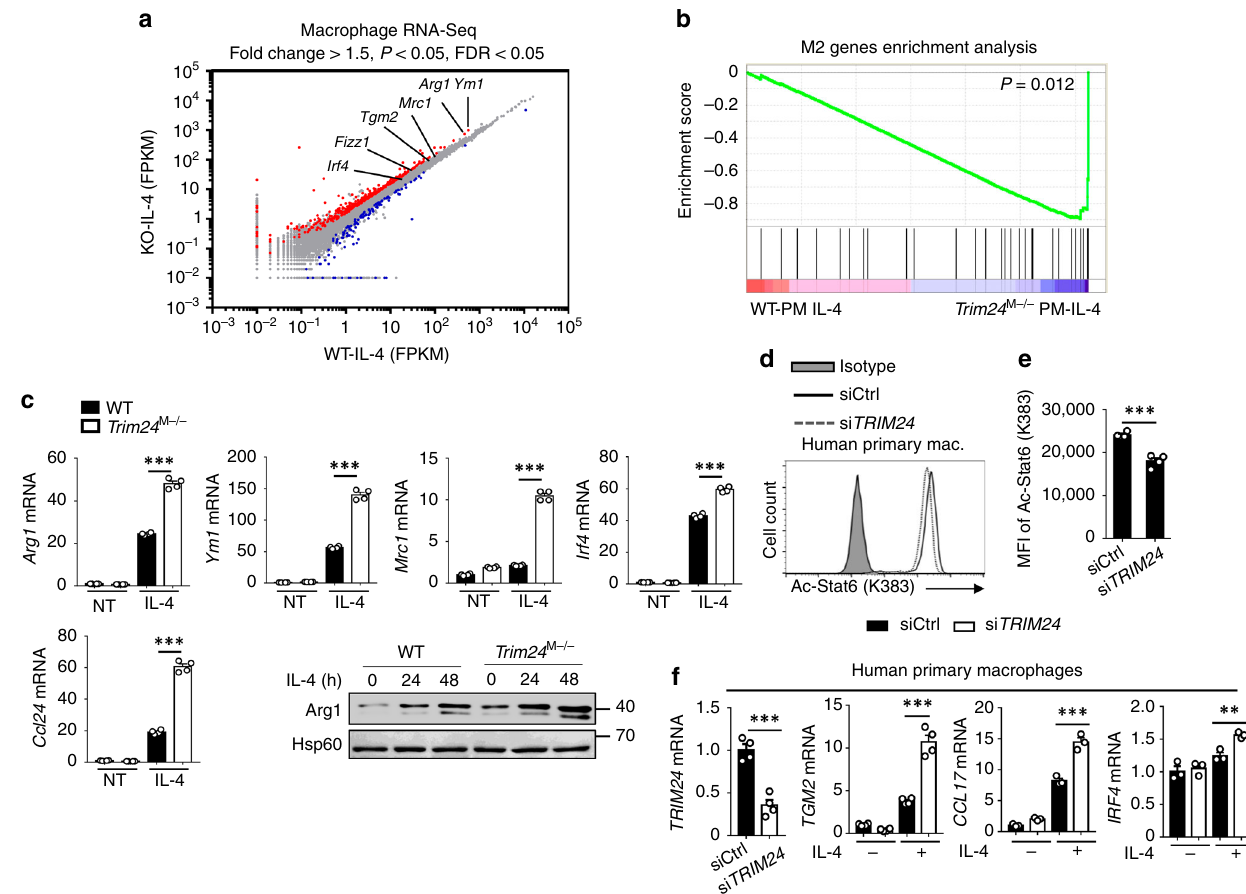
Fig. 6 Trim24 negatively regulated macrophage M2 polarization. a RNA-sequencing analysis showing differentiated gene expression pro fi les in WT and Trim24 -de fi cient macrophages stimulated with IL-4 for 6 h. Representative M2 genes that were upregulated in Trim24 -de fi cient macrophages are indicated in the scatter plot. b Gene set enrichment analysis (GSEA) of the M2 gene set in WT and Trim24 -de fi cient macrophages stimulated with IL-4 for 6 h by using the RNA-sequencing data from ( a ). c QPCR and immunoblot analysis of M2 gene expression in WT and Trim24 -de fi cient macrophages that were left nontreated (NT) or stimulated with IL-4. d , e Flow cytometric analysis of endogenous Stat6 acetylation at Lys383 in control and TRIM24- knockdown human peripheral blood mononuclear cell (PBMC)-derived primary macrophages that were stimulated with IL-4 for 30 min. Data are presented as a representative histogram ( d ) and summary bar graph ( e ). f QPCR analysis of TRIM24 , TGM2 , CCL17 , and IRF4 mRNA in control and TRIM24- knockdown human PBMC-derived primary macrophages that were left nontreated ( − ) or stimulated ( + ) with IL-4 for 6 h. Data with error bars are represented as mean ± SD. Each panel is a representative experiment of at least three independent biological replicates. ∗ p < 0.05, ∗∗ p < 0.01, ∗∗∗ p < 0.001 as determined by the unpaired Student ’ s t test. Source data are provided as a Source Data fi